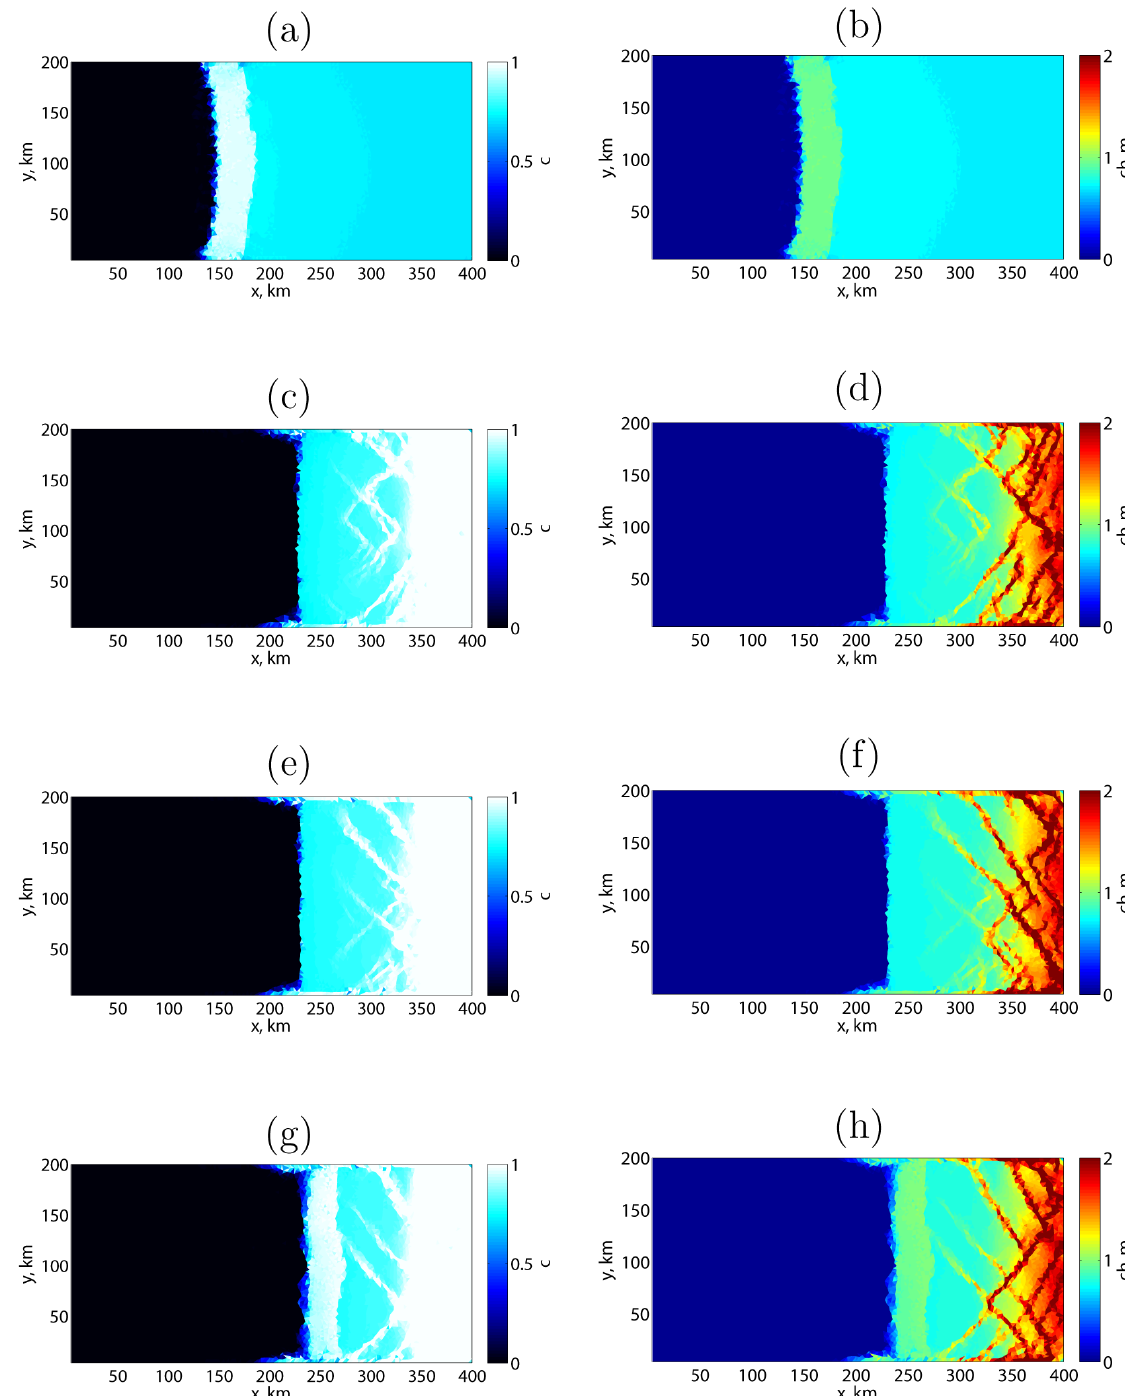
Figure 10. (a, b) Concentration ( c ) and effective thickness (ch) after the same experiment as Fig. 7. (c, d) Same as Fig. 1c, d: wind forcing only. Panel (e–h) show results when steady waves (with H s = 5m, T p = 11 . 2s, from the left) are applied in addition to the wind forcing. Initial ice conditions are the same as in Fig. 7. In (e, f) the ice rheology is not affected by the ice breakage, but in (g, h) damage is set to = 4kPa, C = 40, and the small-scale cohesion is τ S = d break = 0.9999. The large-scale cohesion is τ L 0 0